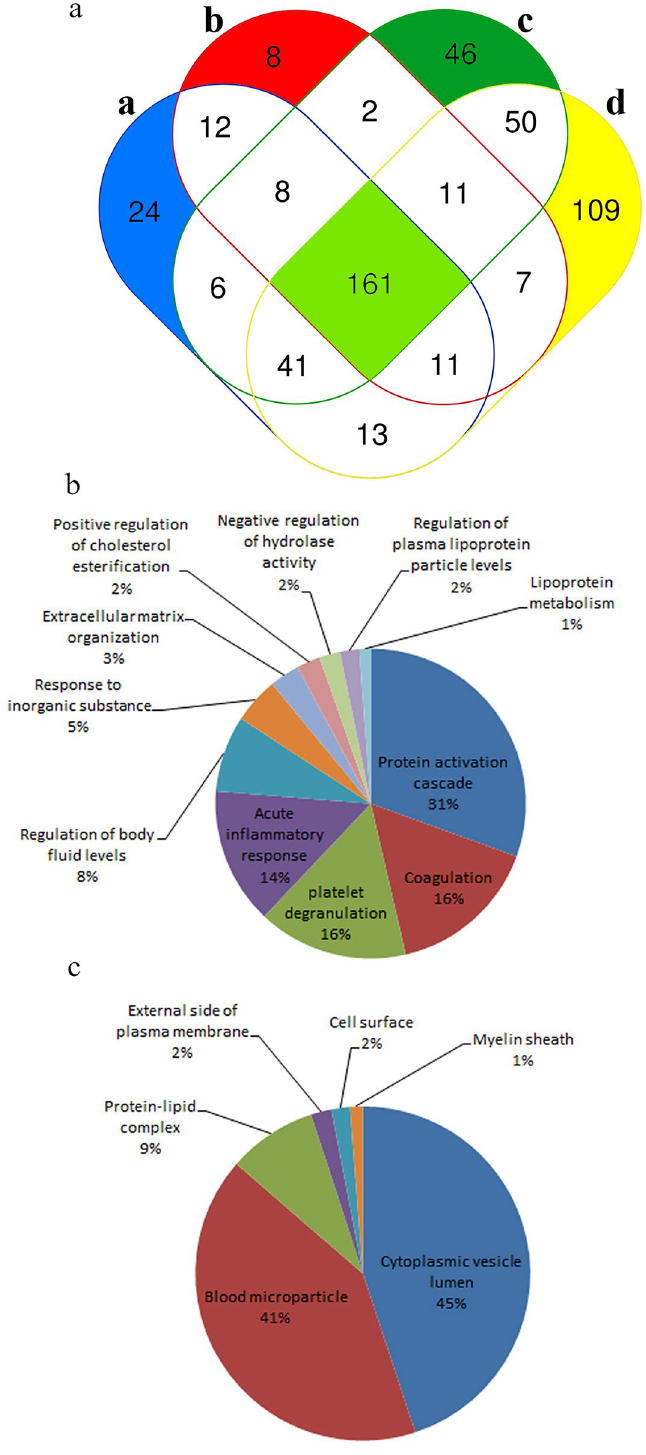
Figure 6. Mass spectrometry results for proteins extracted from Vn96-isolated plasma EVs (n = 4). ( a ) Venn diagram demonstrating the overlap of proteins from each patient. A web-based tool was used to generate Venn diagrams (http:// bioin forma tics. psb. ugent. be/ webto ols/ Venn/, accessed on 28/01/2021). Gene ontology analysis categorized by biological process ( b ) and cell component ( c ). Revigo web-based tool was used to generate figures.